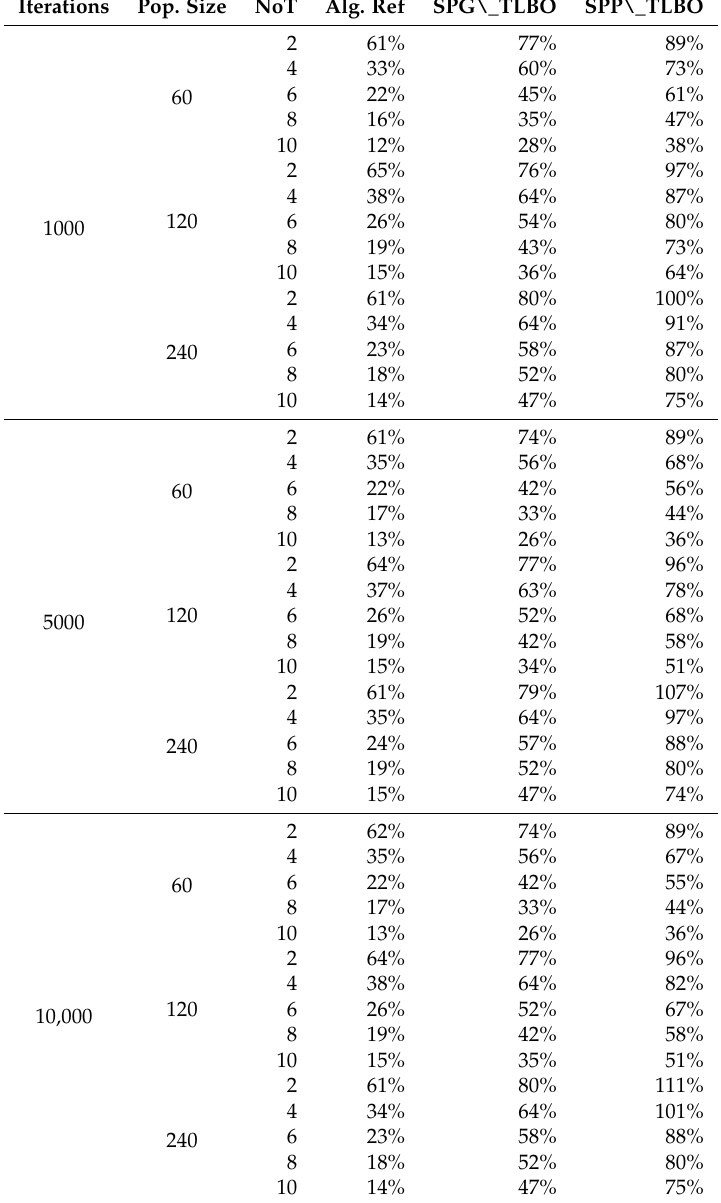
Table 8. Comparison of SPG_TLBO and SPP_TLBO respect to algorithm presented in [14]. Iterations Pop.